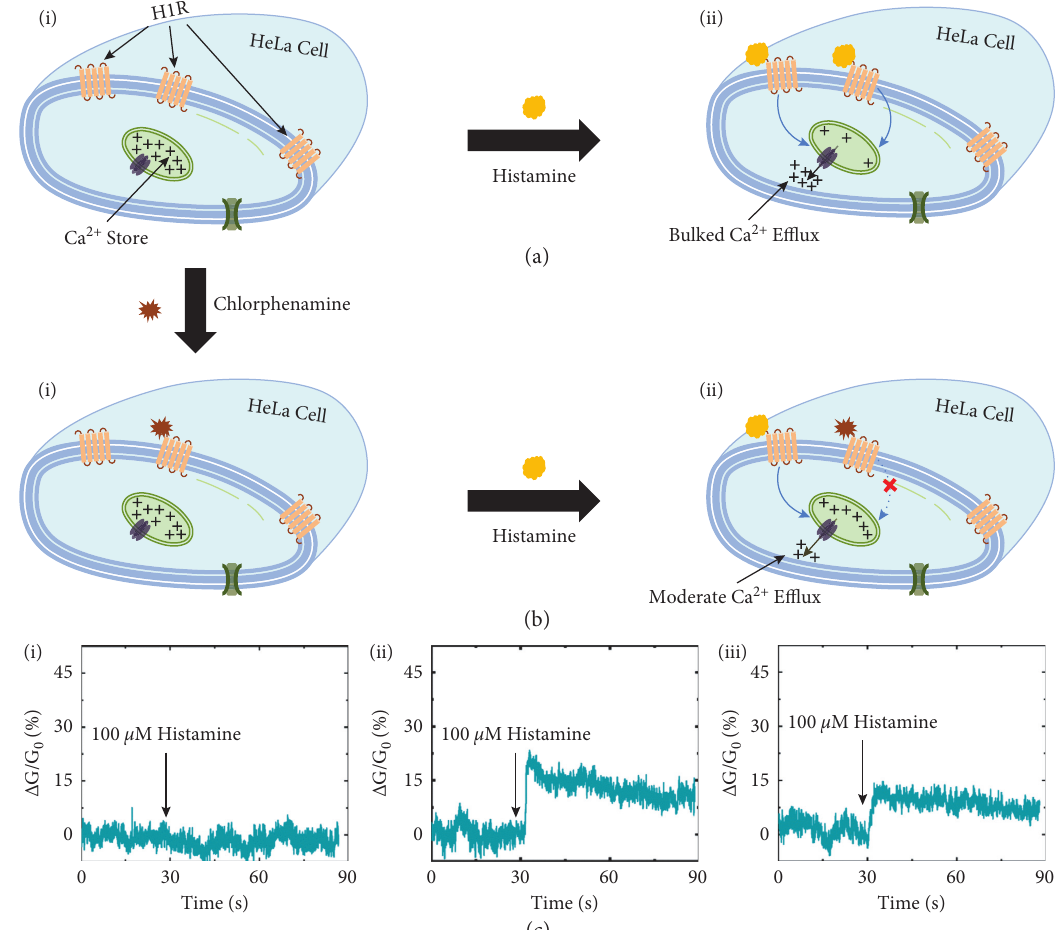
Figure 3: Real-time monitoring of the electrophysiological activities of a HeLa cell under histamine stimulation. (a) Schematic drawing depicting the mechanism of Ca 2+ release from intracellular stores of HeLa cells stimulated by histamine: (i) resting state of a HeLa cell; (ii) stimulation of H1Rs by histamine resulting in the Ca 2+ release from intracellular stores. (b) Schematic drawing depicting the effects of chlorphenamine on histamine-induced Ca 2+ release from intracellular stores: (i) inactivation of H1Rs by chlorphenamine; (ii) reduction of histamine-induced Ca 2+ release caused by a cell pretreatment with chlorphenamine. (c) Real-time monitoring of the conductance changes of a SCN device (i) without a HeLa cell, (ii) with a chlorphenamine nontreated HeLa cell, and (iii) with a chlorphenamine pretreated HeLa cell during the addition of 100 μ M